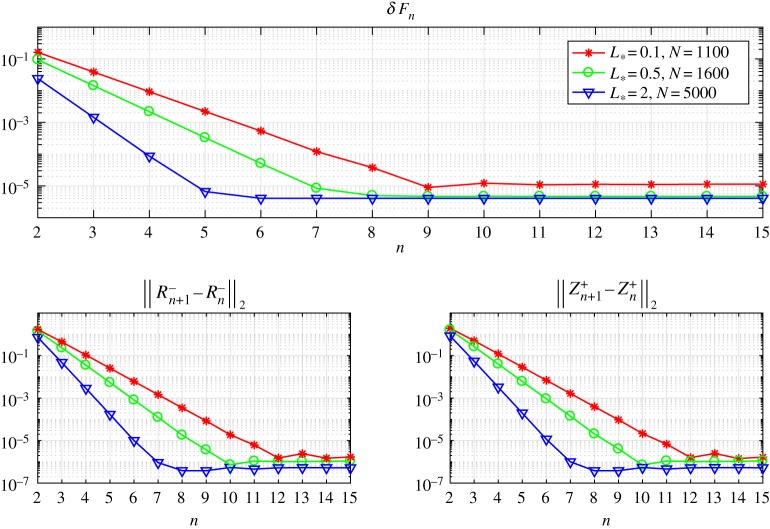
The discrepancy of the equation and the norms of errors versus the number of iterations for various numbers of integration points N. (Online version in colour.)